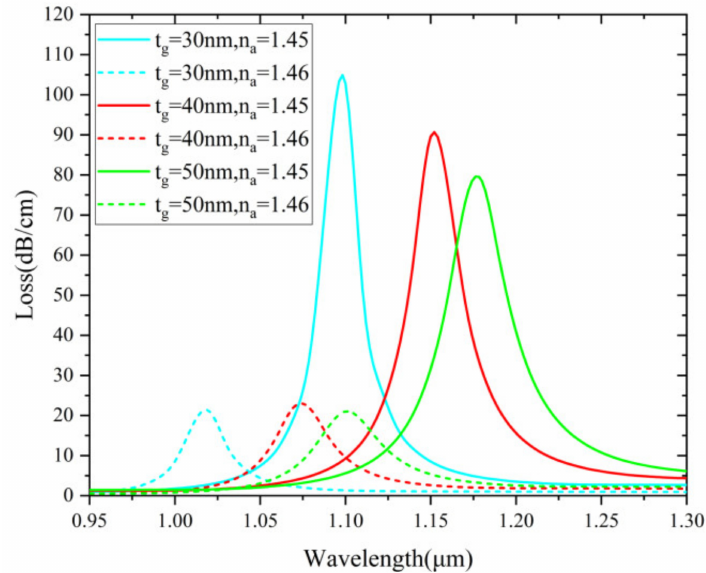
Figure 11. Loss spectra (n a = 1.45 and 1.46) when t g is varied from 30 to 50